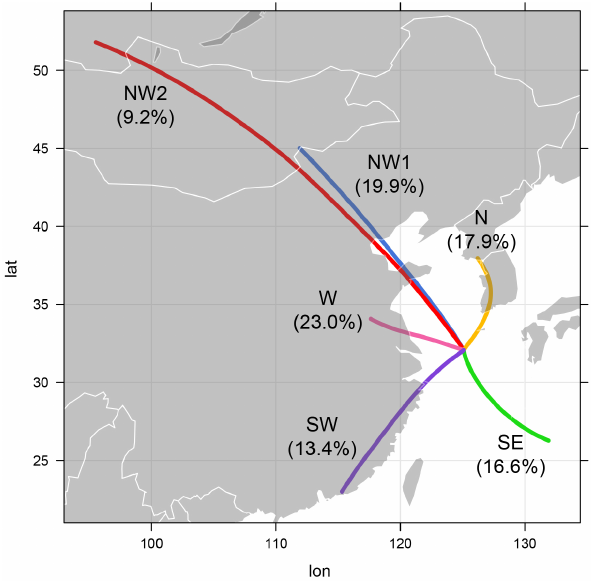
Figure 7. Mean trajectories of air masses classified into six groups. Air masses of 1500m altitude were traced backward for